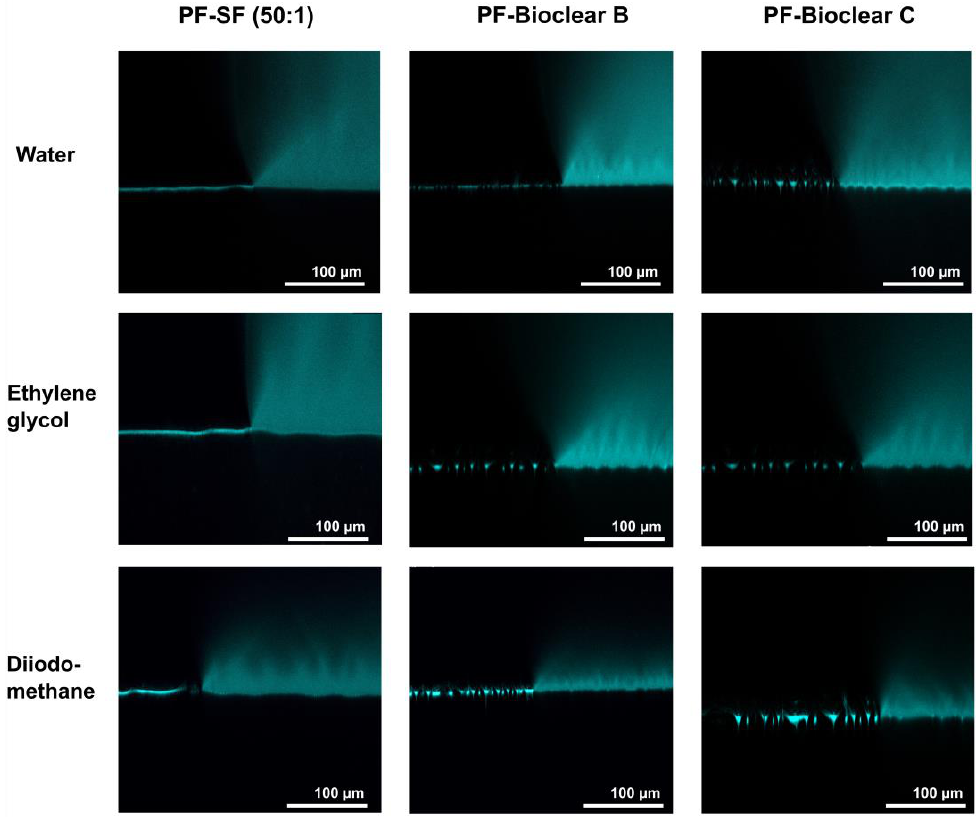
Figure 5. Confocal microscopy images of the three-phase contact line area of 5 µ L droplets of water, ethylene glycol, and diiodomethane on soft PDMS types SF and Bioclear B and C coated with a thin layer of Parylene F. Droplets were dyed with rhodamine B to increase visibility. The PF coating prevents the diffusion of fluid into the soft material (compare Figure 2). The wrinkles formed by the PF coating are clearly visible on the surfaces.